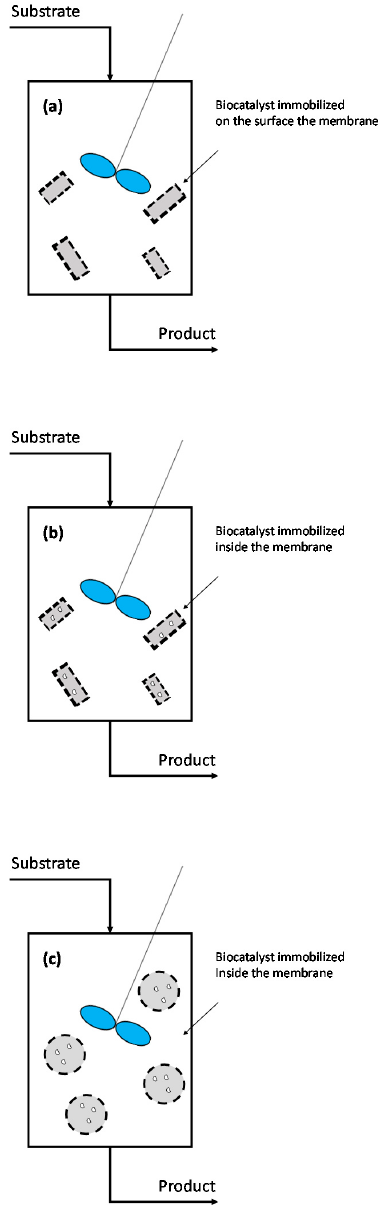
Figure 20. ( a ) Schematic of a Continuous Stirred MBRs in which enzymes are immobilized on the surface of the membrane beads; ( b ) CSMBR with immobilized enzymes inside flat membranes; ( c ) CSMBR with immobilized enzymes inside a spherical membrane